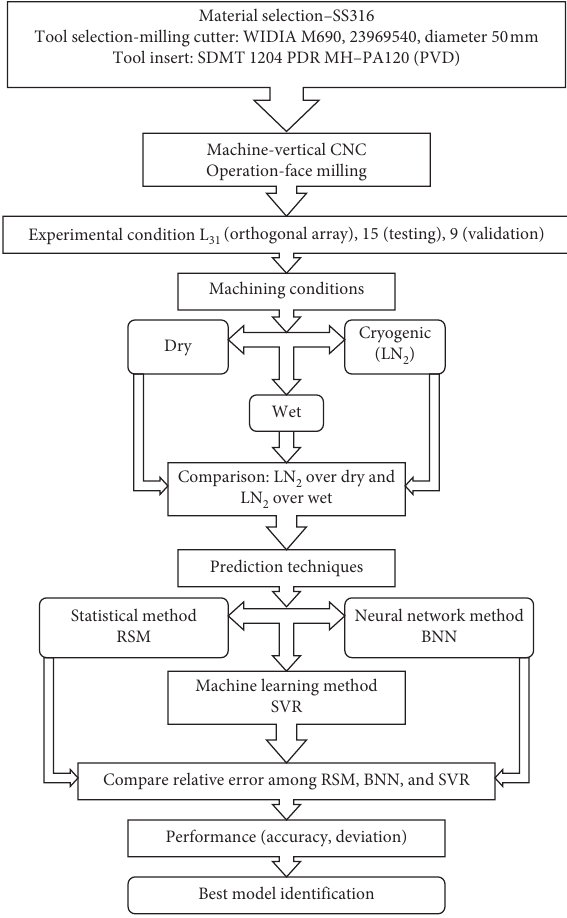
Figure 2: Structure of the article. Table 1: Composition ranges of elements in SS316 grade.